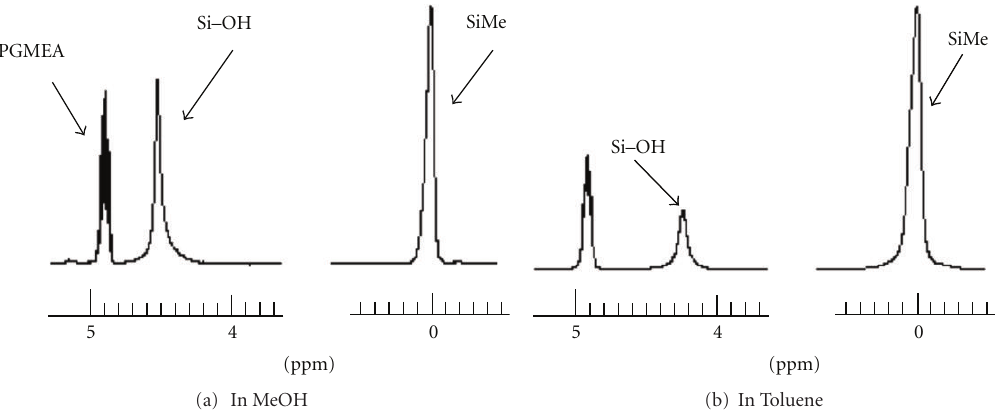
Figure 3: 1 H-NMR spectra of PMSQ; (a) prepared in methanol, (b) prepared in toluene.